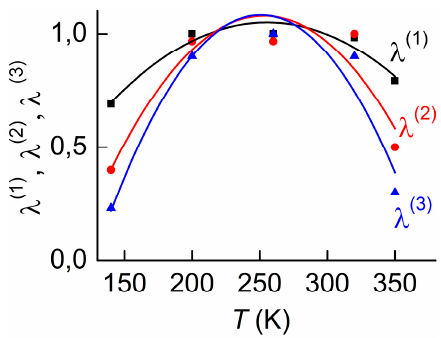
Figure 9. Temperature dependences of derivatives of magnetostriction coefficient on magnetic field for a Metglas layer. Solid lines represent the approximation of data by a second-order polynomial.